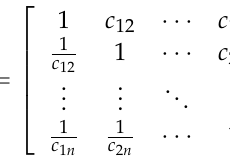
Table 2. Saaty’s scale of relative importance. Intensity of Importance Technology 1 Same importance 2 Intermediate values 3 Relatively more important 4 Intermediate values 5 Some more important 6 Intermediate values 7 Very more important 8 Intermediate values 9 Enormously